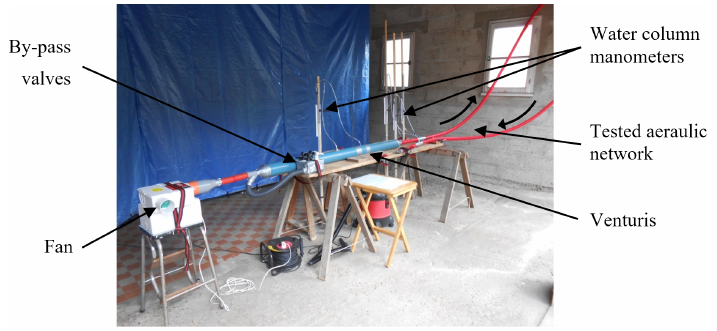
Figure 3. Aeraulic apparatus used for the experimental validation for the design